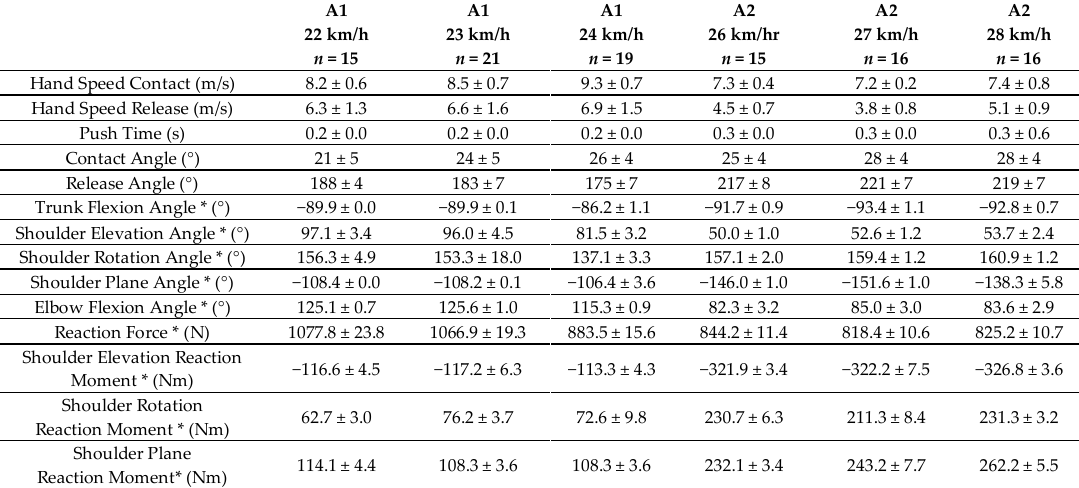
Figure 2. Kinematic comparison of motion for A1 ( left ) and A2 ( right ). Time in contact with the wheel is represented by the grey regions, with guideline references located on the outside of the wheel. Segments presented represent the kinematic tracking of the head, shoulder, elbow and hand markers. Table 1. Kinematic and kinetic characteristics of propulsion presented as mean ±SD; n represents the number of push cycles recorded. * Represents data collected for a single side only. Contact and Release angles are presented to no decimal places to reflect precision of collected